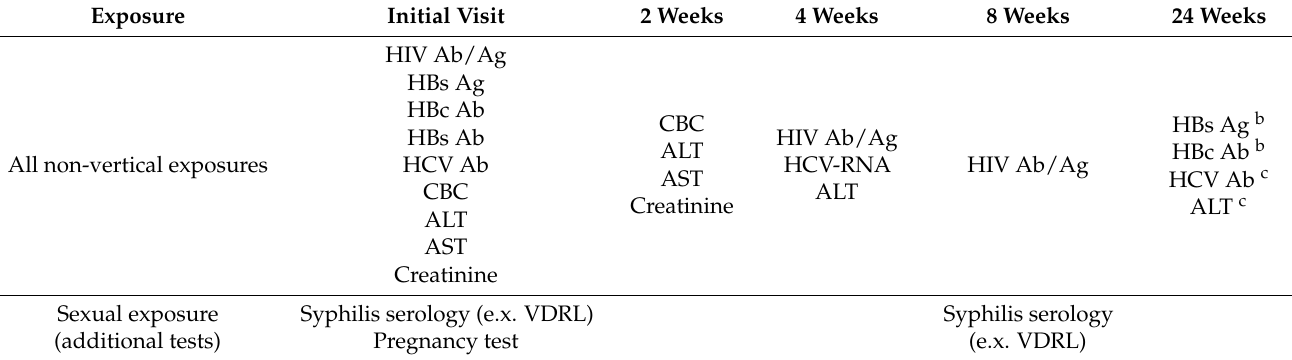
Table 4. Schedule of follow-up visits according to recommendations of Polish AIDS Society, 2021 [36].